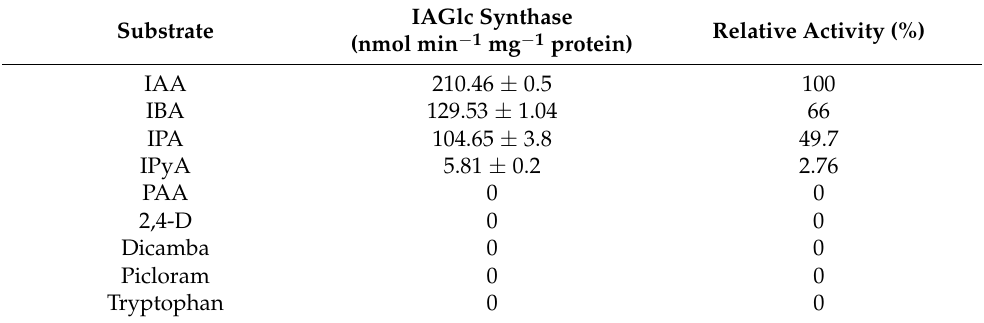
Table 1. Substrate specificity of recombinant IAGlc synthase. Enzyme activity was determined using the spectrophotometric method. Relative activity (%) was calculated taking the IAGlc synthase activity for IAA (nmol min − 1 mg − 1 protein) as 100%. IAA—indole-3-acetic acid; IBA—indole-3- butyric acid; IPA—indole-3-propionic acid; IPyA—indole-3-pyruvic acid; PAA—phenylacetic acid; 2,4-D—2,4-dichlorophenoxyacetic